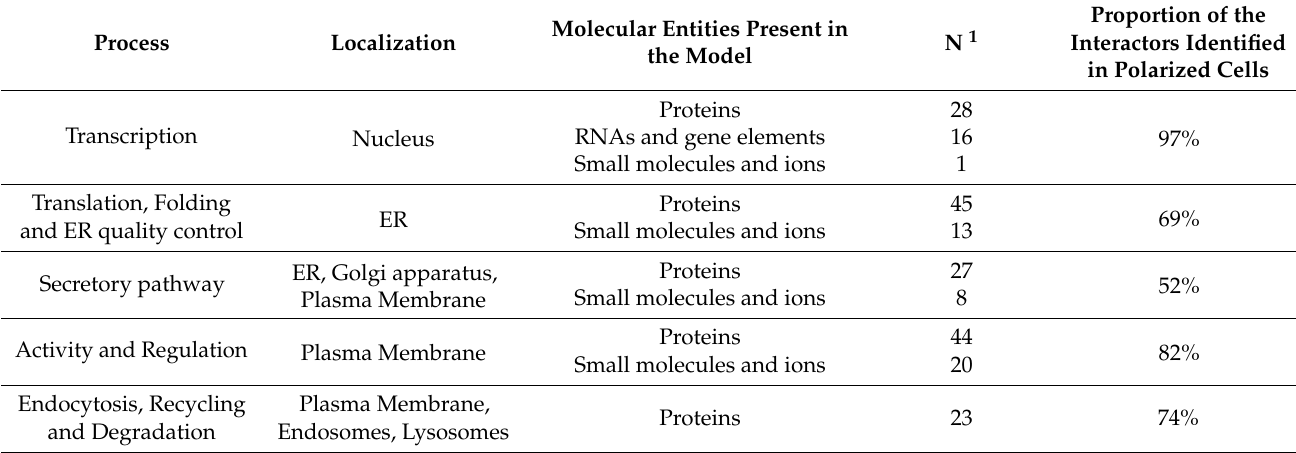
Table 1. Description of the five submaps of the CFTR core